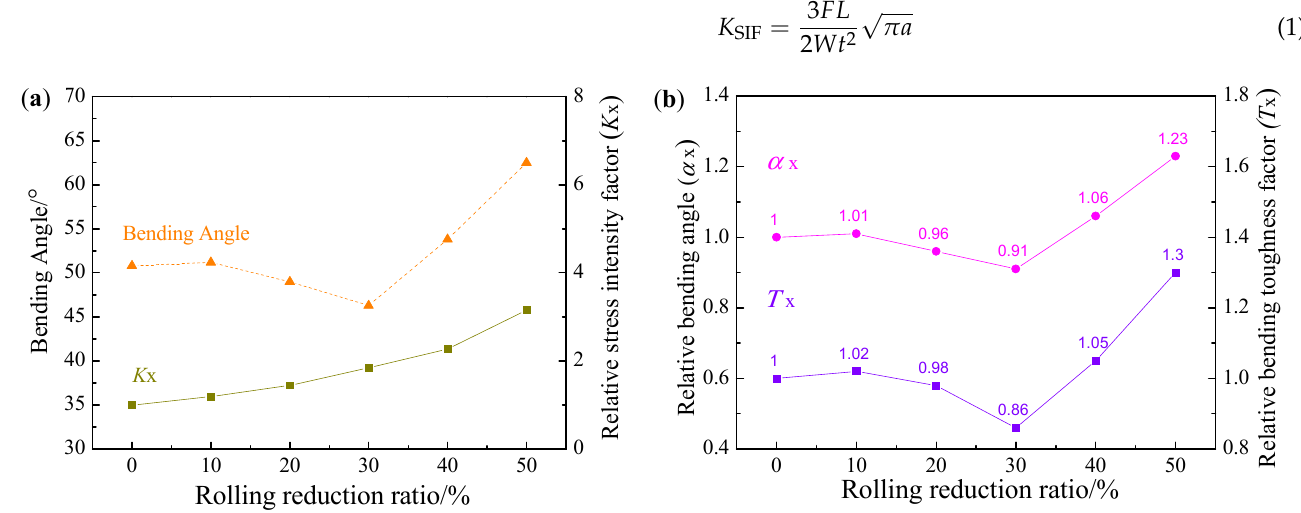
Figure 18. ( a ) Bending angle and Kx at different reduction ratios at TAUS = 930 ◦ C for 5 min; ( b ) α x and T x at different reduction ratios at TAUS = 930 ◦ C for 5